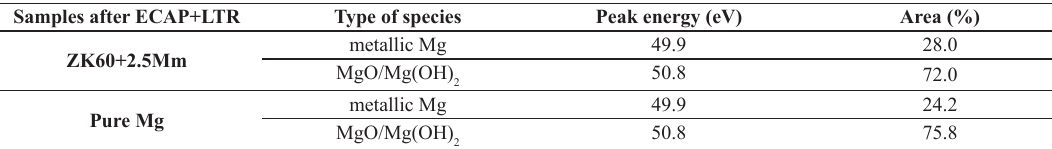
) and reconstructed sample volume (V c